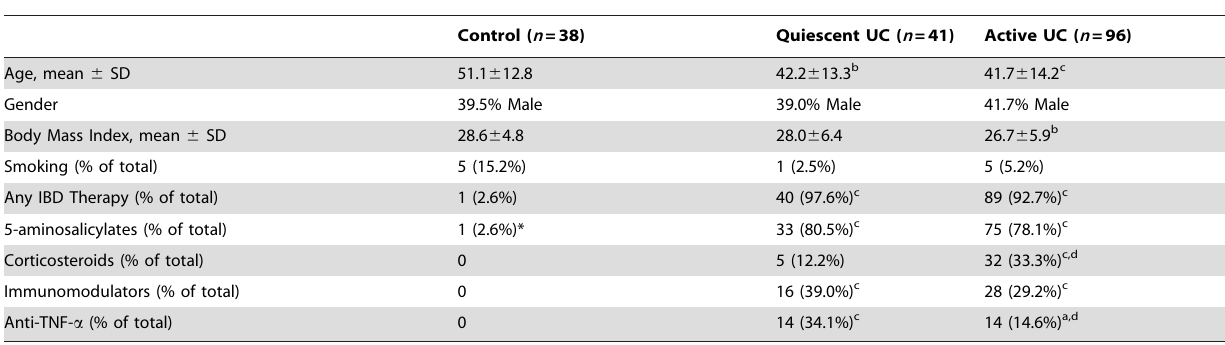
Table 1. Demographic features of the study subjects.